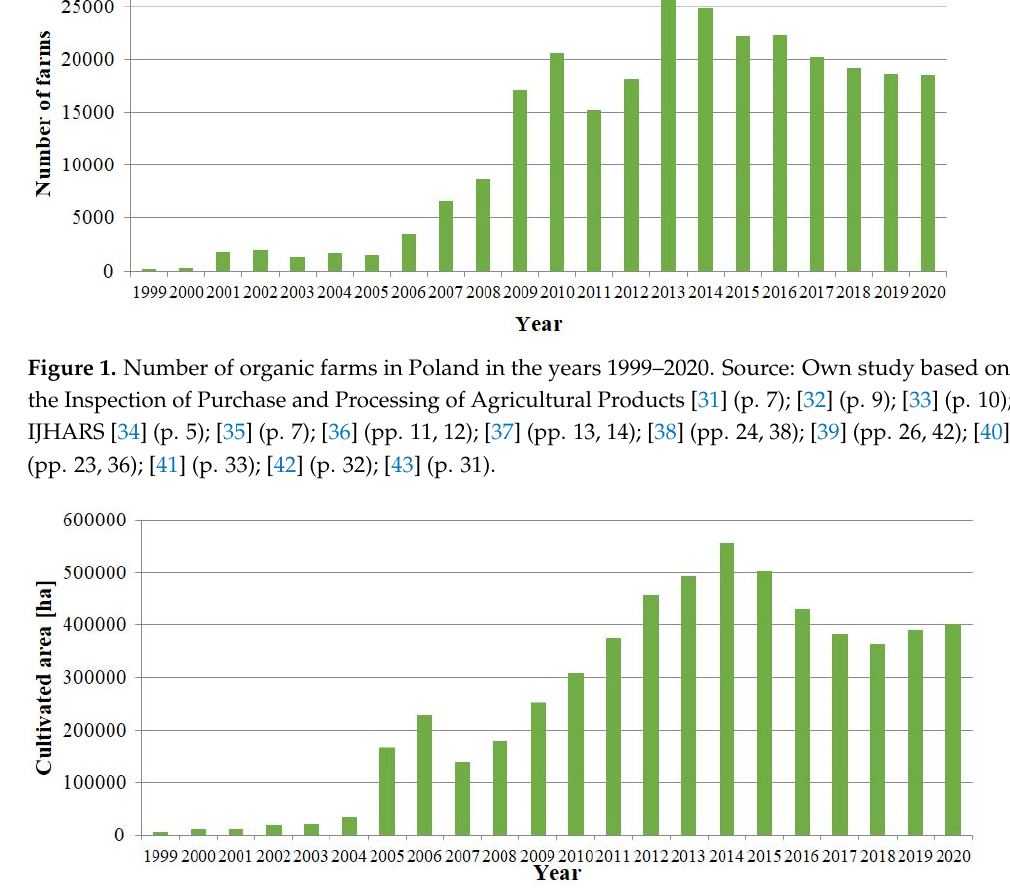
Figure 2. Area of organic farming [ha] in Poland in the years 1999–2020. Source: Own study based on the Inspection of Purchase and Processing of Agricultural Products [31] (pp. 8, 20); [32] (p. 9); [33] (p. 8); IJHARS [34] (p. 8); [35] (p. 8); [36] (p. 15); [37] (pp. 19,20); [38] (p. 40); [39] (p. 43); [40] (p. 37), [41] (pp. 50,51); [42] (pp. 48,49); [43] (pp. 45,46).